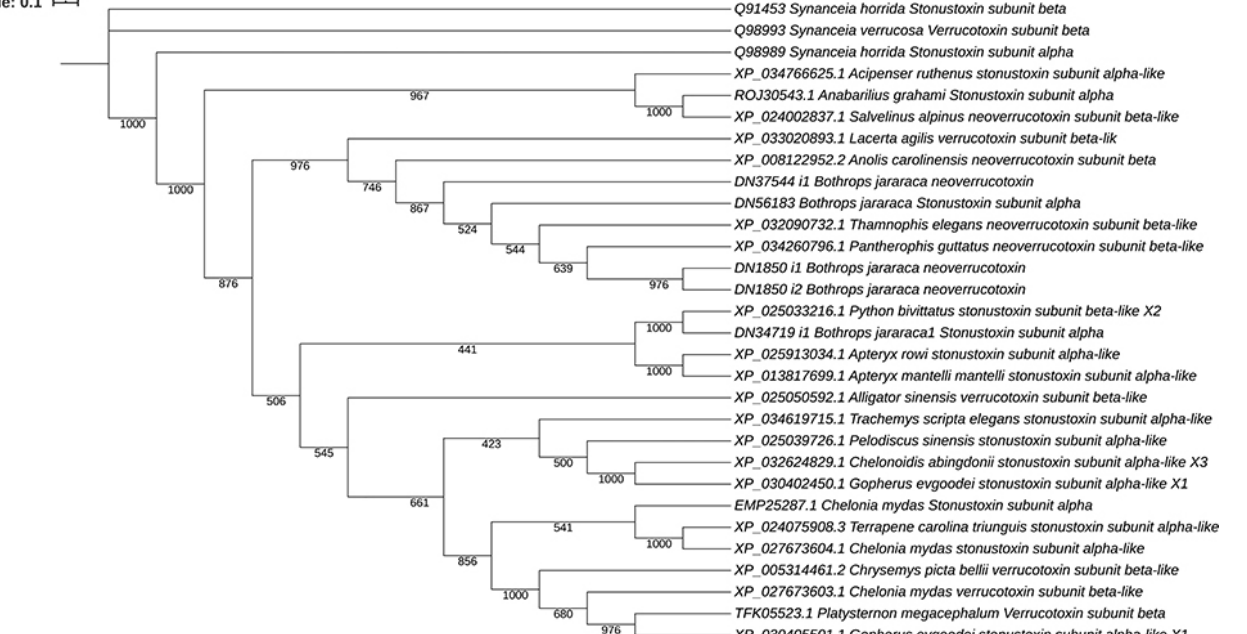
Figure 4. Functional class annotation of toxins and accessory family proteins identified in B. jararaca venom using Animal Toxin Annotation Project as reference.